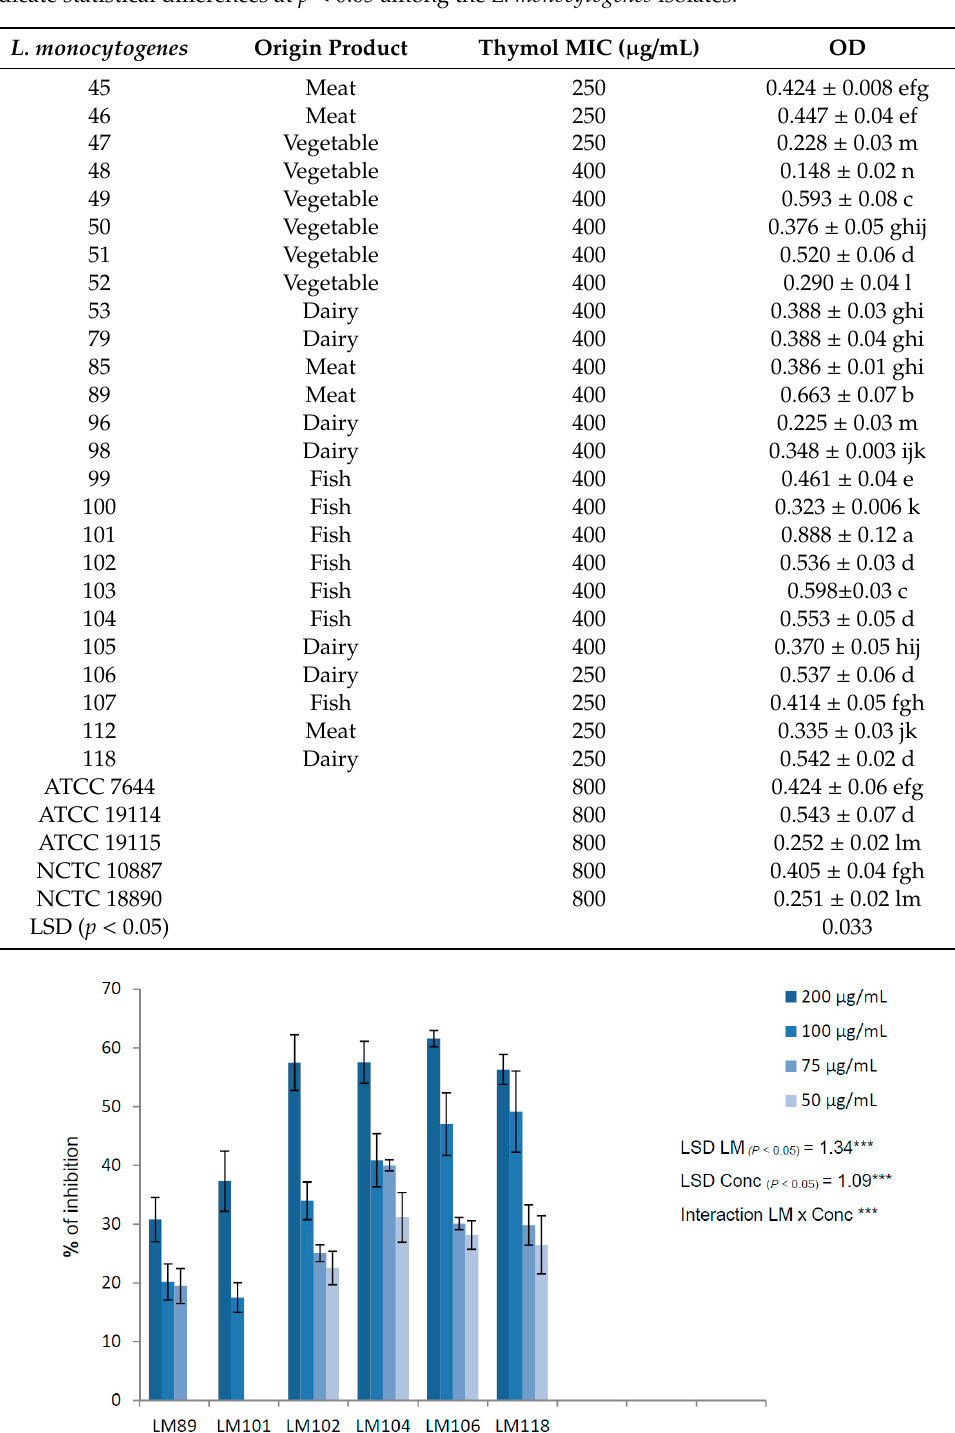
Figure 1. Percentages of inhibition of biofilm formation at sub-MIC concentrations of thymol against the best biofilm producers. The averages from three independent experiments are reported with the SD values. Error bars represent the SD of the data. LSD (least significant di ff erence) was calculated at 0.05 probability level by the Student–Newman–Keuls (SNK) test